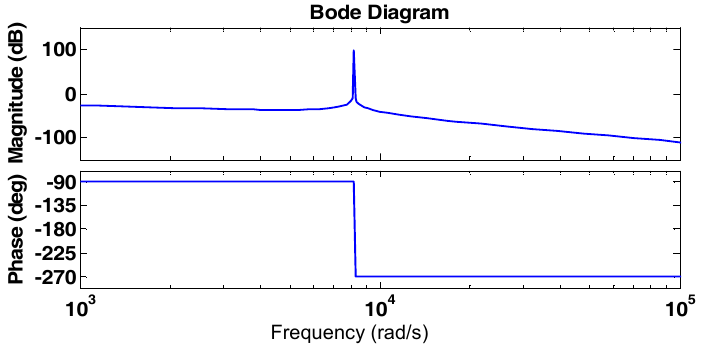
Figure 11. Bode plot of grid connected LCL filter.